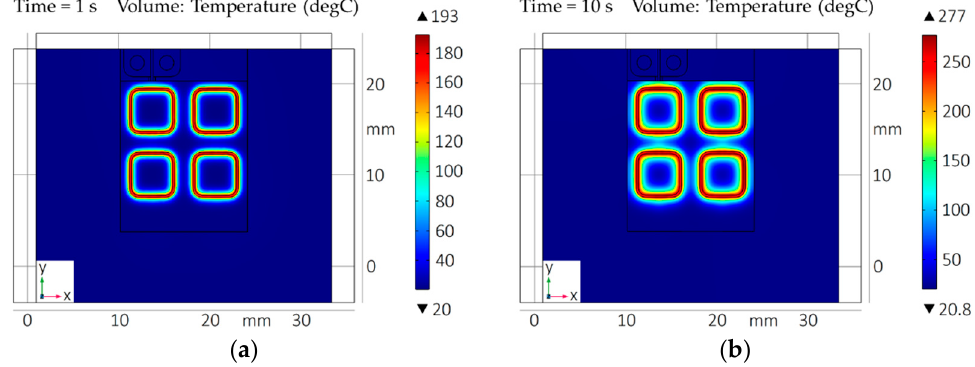
Figure 18. FE simulation of the thermal management for the resulting inductive heating of the bond frames in relation to the bond substrate, the micro coil, and the heat sink: ( a ) Temperature distribution after t h = 1 s; ( b ) Temperature distribution after t h = 10 s.